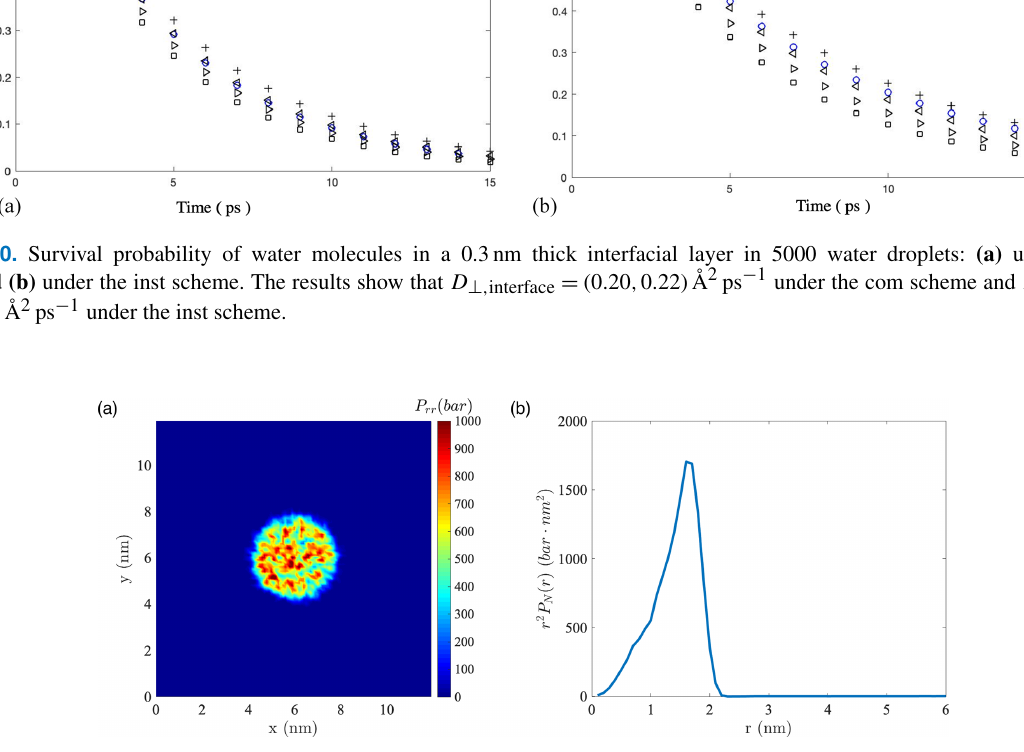
Figure A11. (a) Instantaneous normal pressure tensor in 1000 water droplets at the equatorial plane perpendicular to the z axis. (b) Instan- taneous value of r 2 P N ( r ) versus the radial coordinate in the droplet containing 1000 water molecules.